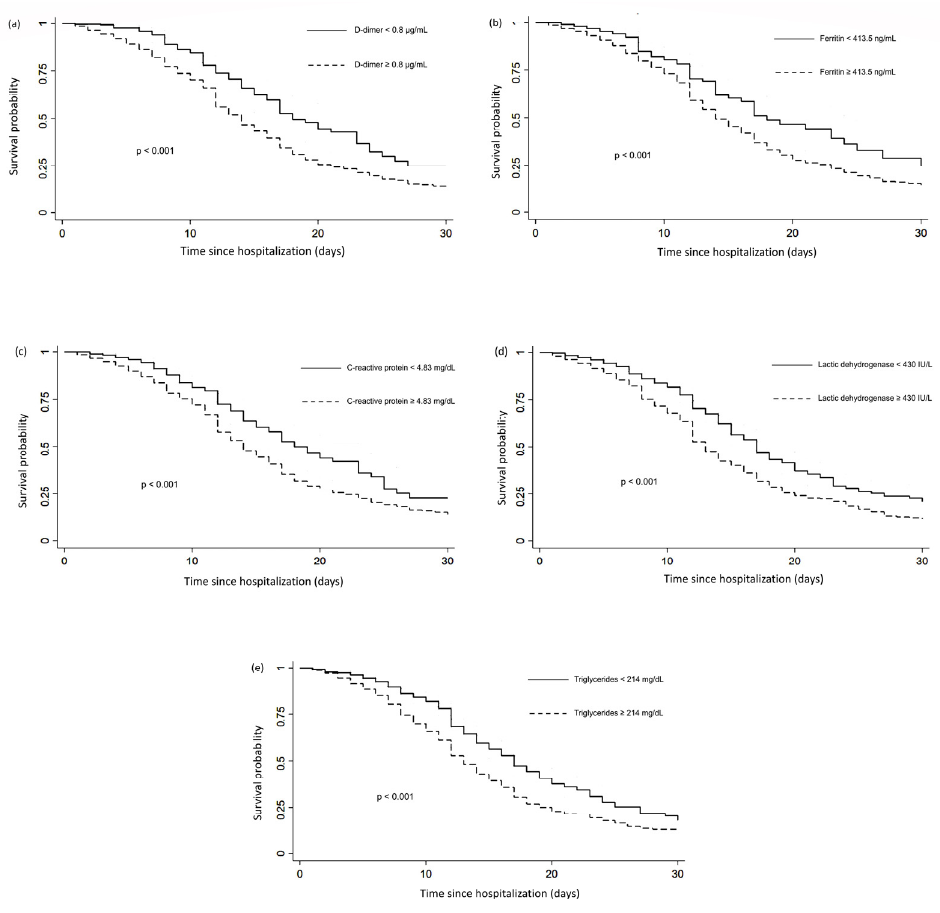
Figure 4. Thirty-day survival of hospitalized COVID-19 patients after hospital admission stratified by D-dimer ≥ 0.8 µ g/mL, ( a ) ferritin ≥ 413.5 ng/mL, ( b ) C-reactive protein ≥ 4.83 mg/dL, ( c ) lactic dehydrogenase ≥ 430 IU/L, ( d ) triglycerides ≥ 214 mg/dL, and ( e ) (n =